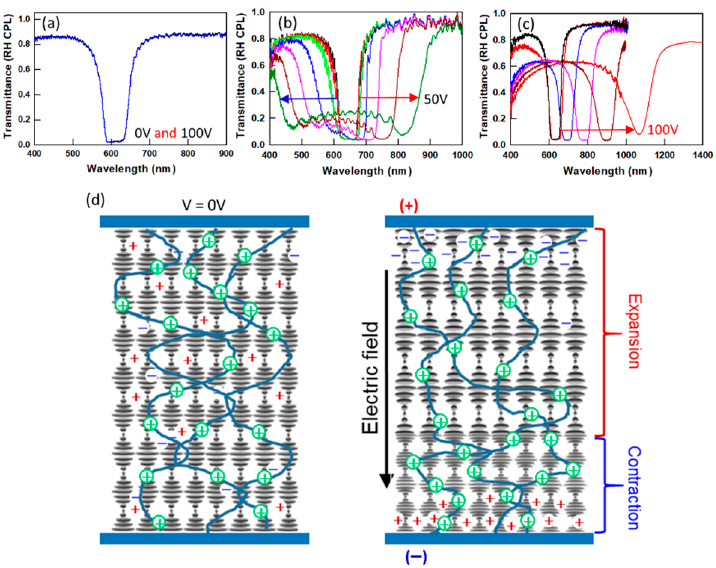
Figure 1. Electro-optic response of PSCLCs with negative dielectric anisotropy formulated with 6 wt% C6M, 6 wt% R1011, 5 wt% R811 and 84 wt% MLC-2079 ( a ) before and after 5 min UV exposure showing ( b ) bandwidth broadening of PSCLC with 1 wt% Irgacure 651 and ( c ) red shifting tuning of PSCLC with 1 wt% Irgacure 369. Right-handed circularly polarized light (RH CPL) is used as a probe beam to match the handedness of the PSCLC samples. Cells of 15 μ m thickness were used and the chemical structures of the materials used for this study are shown in Figure S1. ( d ) Schematic of the polymer network in a deformable PSCLC with Δε < 0: (left image) with no applied field, (right image) with a DC field applied between the top and bottom substrates. The blue lines represent the polymer network, the grey horizontal bars are the low-molecular weight CLC molecules, + and − are the free cationic and anionic impurities and ⊕ are trapped cationic impurities. Adapted from Reference